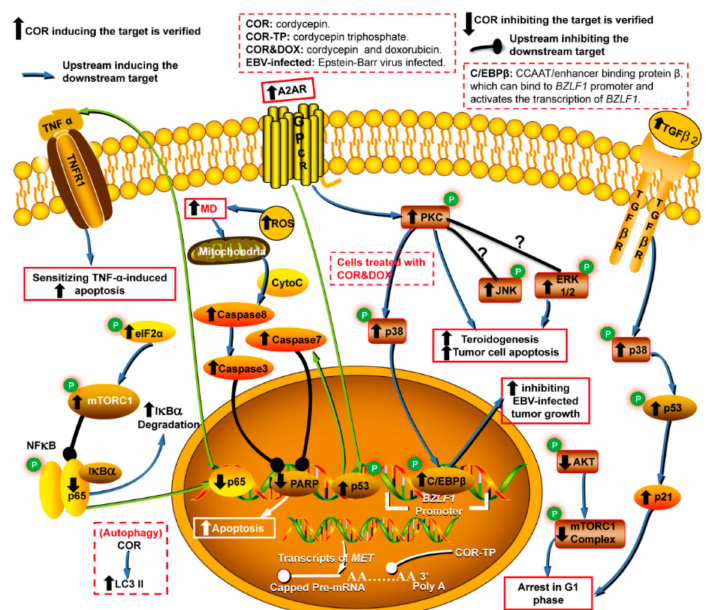
Figure 2. Cellular targets of tumor a ff ected by cordycepin via various signal pathways. Note: ROS: reactive oxygen species. C / EBP β : CCAAT / enhancer binding protein β , which can bind to BZLF1 promoter and activate the transcription of BZLF1 [17]. MD: mitochondrial disfunction. These abbreviations are also used in this paper.